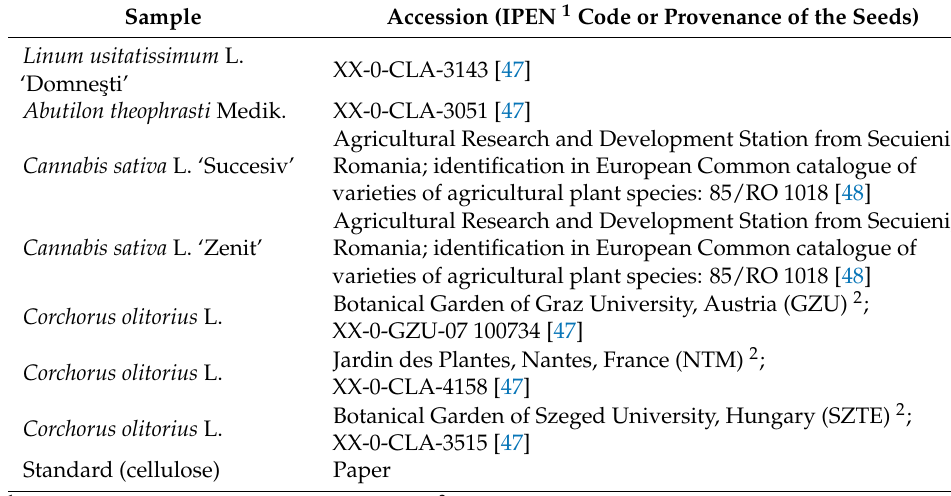
Table 2. Samples analyzed through FT-IR